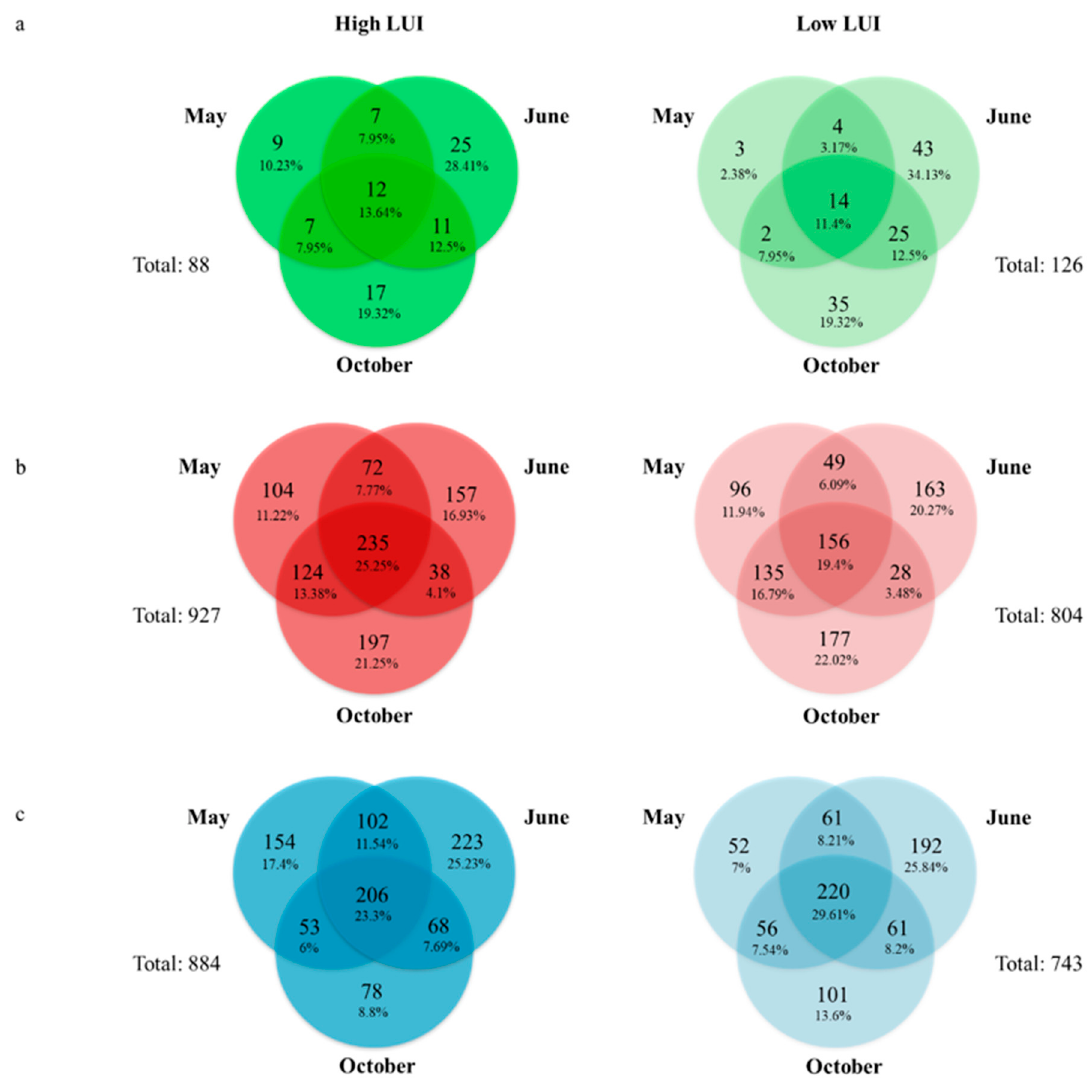
Figure 2. Shared operational taxonomic units (OTUs) between the different sampling seasons May, June and October for both land use intensities (LUIs). Green depicts root samples ( a ), red depicts rhizosphere samples ( b ) and blue depicts bulk soil samples ( c ). The percentages are based on the total amount of OTUs that contribute to the diagram.